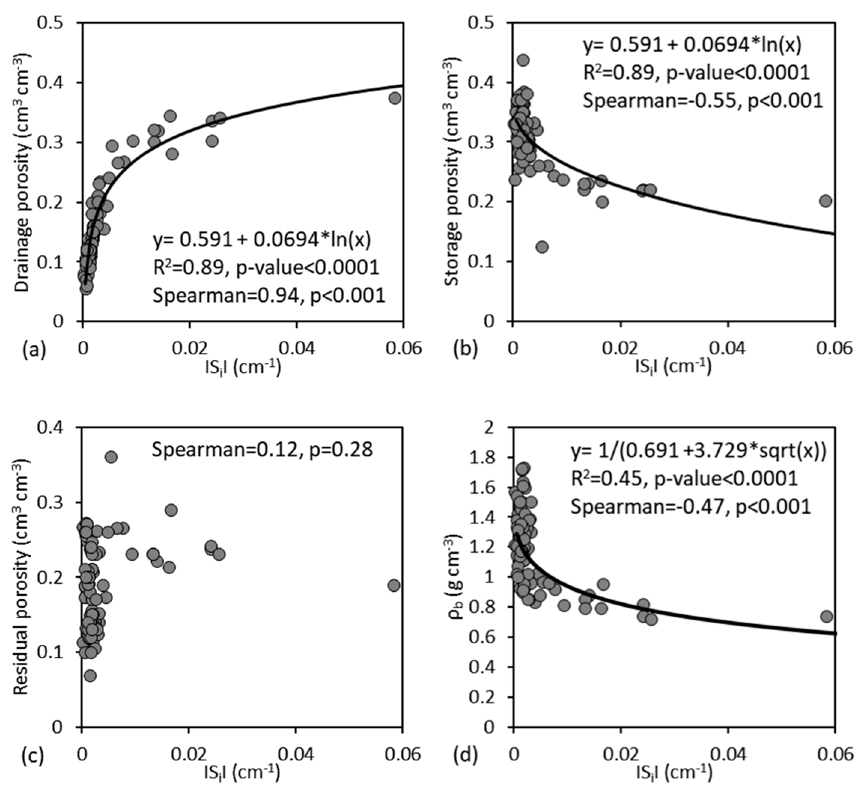
Figure 8. Spearman correlations and regression analysis between |S i | and drainage, storage, residual porosity, and ρ b using the pooled data from all soils and treatments.